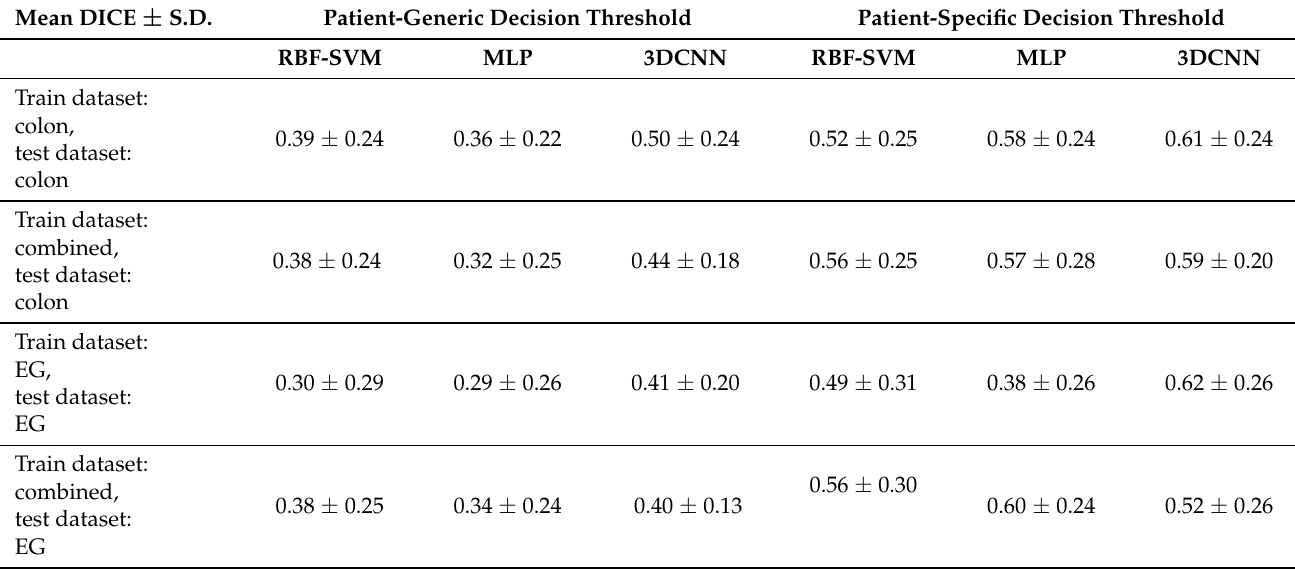
Table 7. DICE performance of different models evaluated on the colon and esophagogastric (EG) datasets. Mean DICE ±